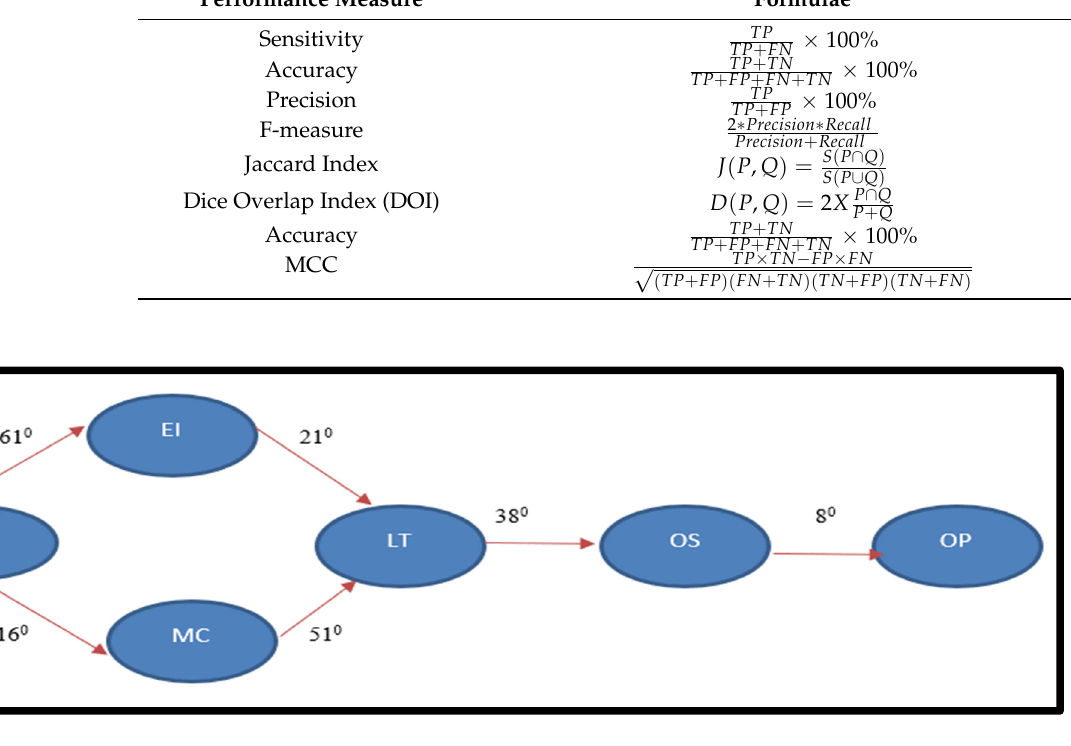
Figure 7. Exploratory factor analysis for sea lion optimization algorithm. Table 10. Analysis on computational time for different classifiers.